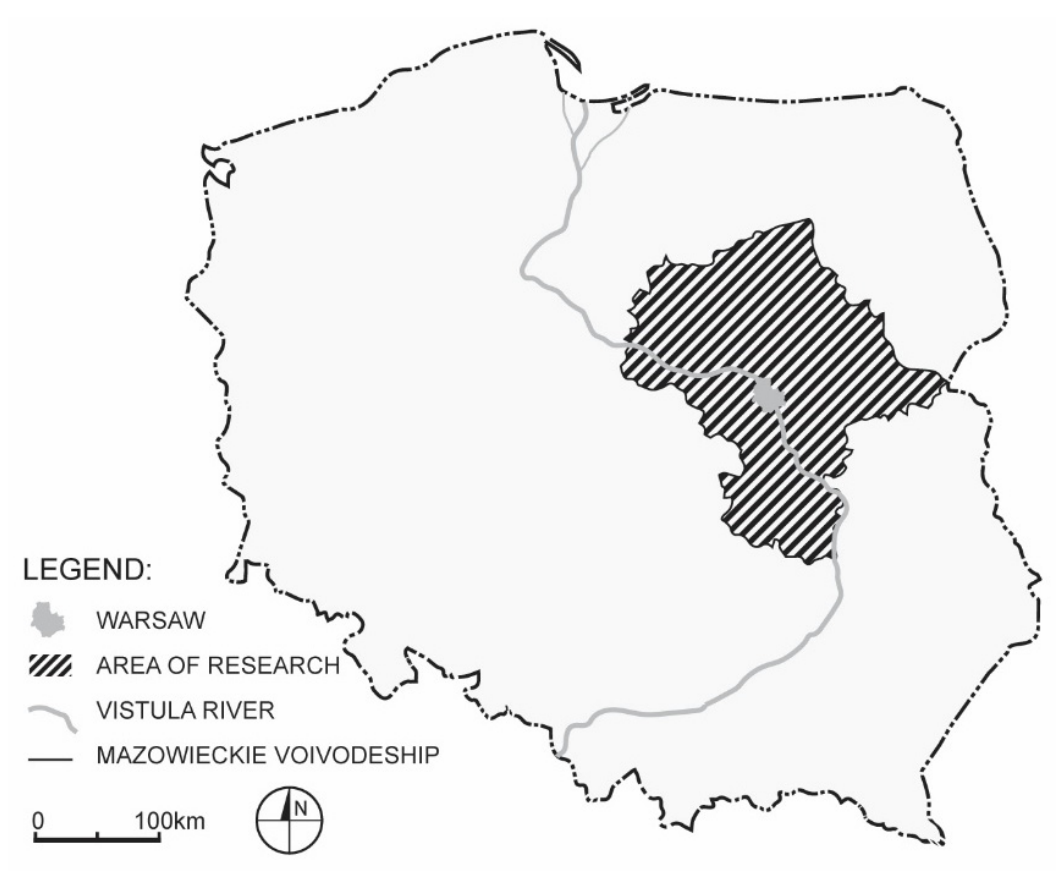
Figure 4. Location of the research area in Poland. Source: own study.